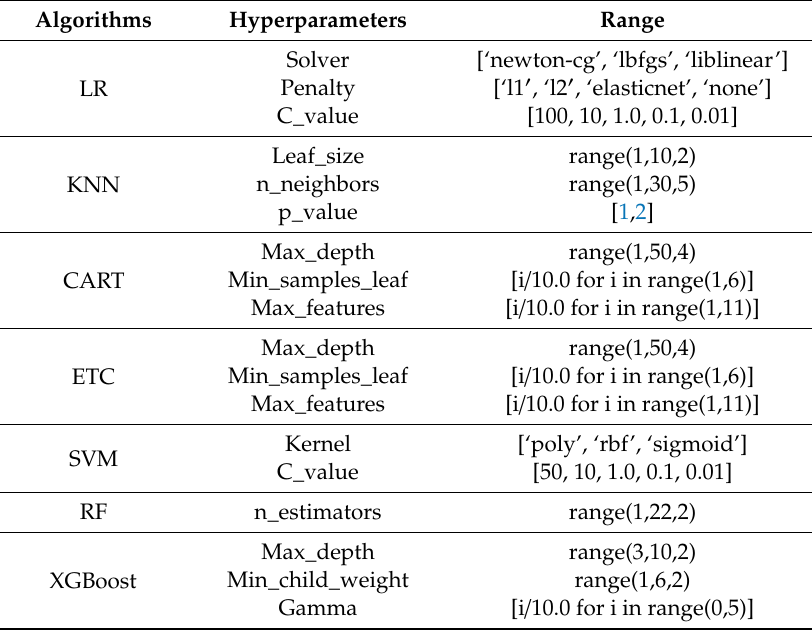
Table 7. Hyperparameters tuning